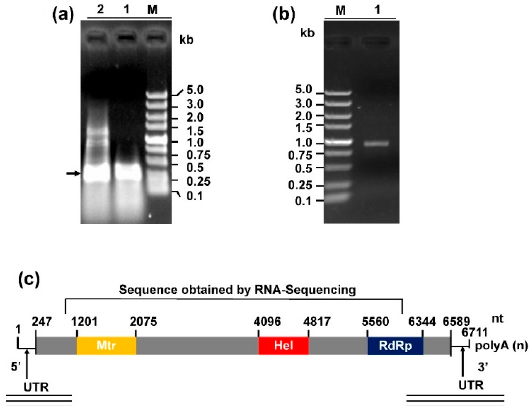
Figure 3. Cloning of the termini of the SsDFV2 genome and a schematic of the viral genome. ( a ) 5 RACE. Lane M, DL5000 DNA marker; Lane 1, band containing the 5 terminal sequence of SsDFV2 in strain 228; Lane 2, nested PCR producing more than one band. The bands of approximately 1.5, 1.0, and 0.45 kb were sequenced, and the 0.45 kb band (arrow) contained 5 terminal overlapping sequence, whereas the two larger bands were S. sclerotiorum genes. ( b ) 3 RACE. Lane M, DL5000 DNA Marker; Lane 1, band containing the 3 terminal sequence of SsDFV2, with a Poly-T tail, from strain 228. ( c ) Schematic representation of the genomic organization of SsDFV2. The open reading frame is represented by the box. Nucleotide numbers are indicated. Mtr, viral methyltransferase; Hel, helicase 1; RdRp_2, RNA dependent RNA polymerase, lines under the sketch represent sequenced RACE clones.